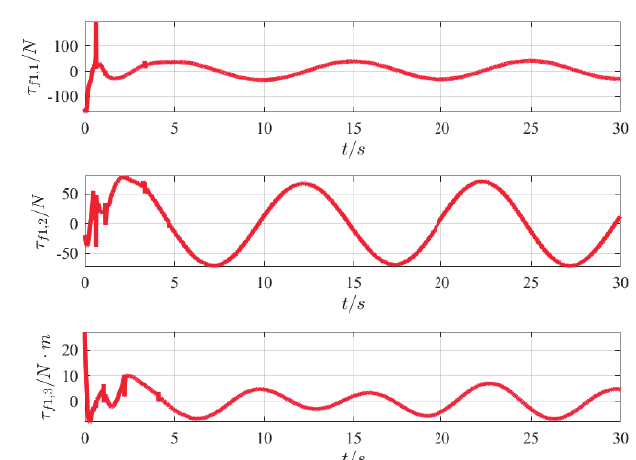
Figure 12. Control inputs of followers.